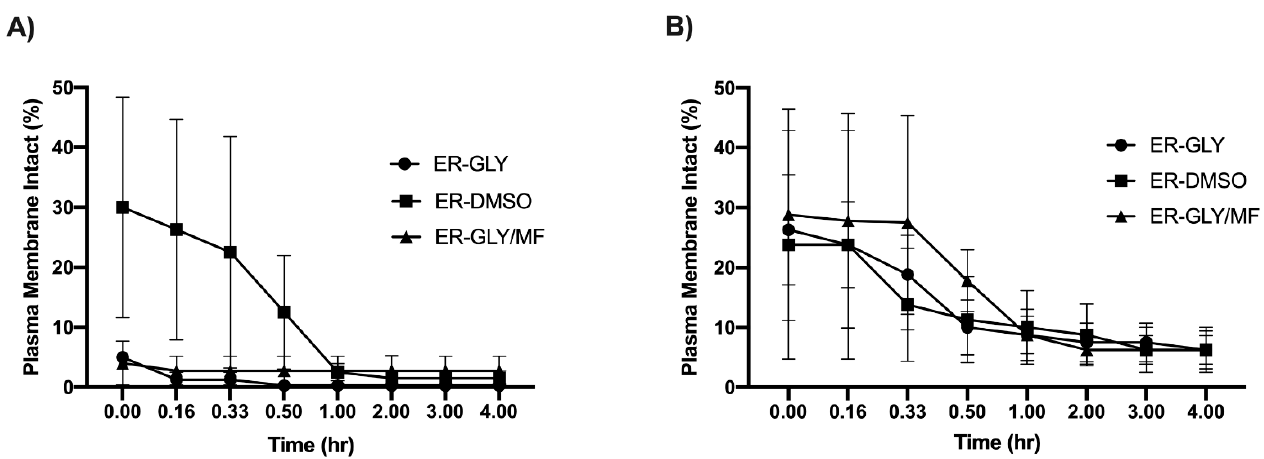
Figure 3. Plasma membrane integrity ( x ± SEM) of frozen-thawed southern stingray ( Hypanus americanus ) sperm (March n = 1, June n = 3) in using ( A ) conventional and ( B ) modified slow freeze methods. ER = Hank’s elasmobranch ringer solution; GLY = glycerol; DMSO = dimethyl sulfoxide; MF = N-methylformamide.